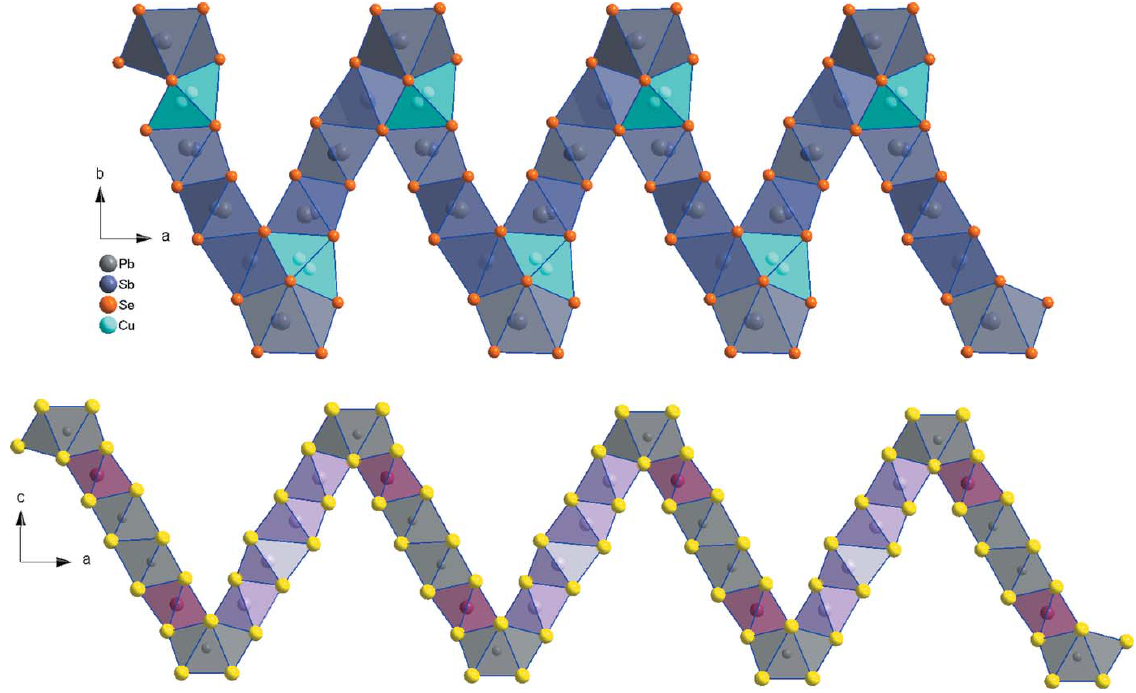
Figure 4 Comparison of four-polyhedra-long chains delimited by the Pb1/Sb1 position in (top) CuPbSb 3 Se 6 and (bottom) the lillianite 4 L-type structure of SnPb 2 Bi 2 S 6 . Colour codes: Bi red, Pb grey, Bi/Sn pink, S